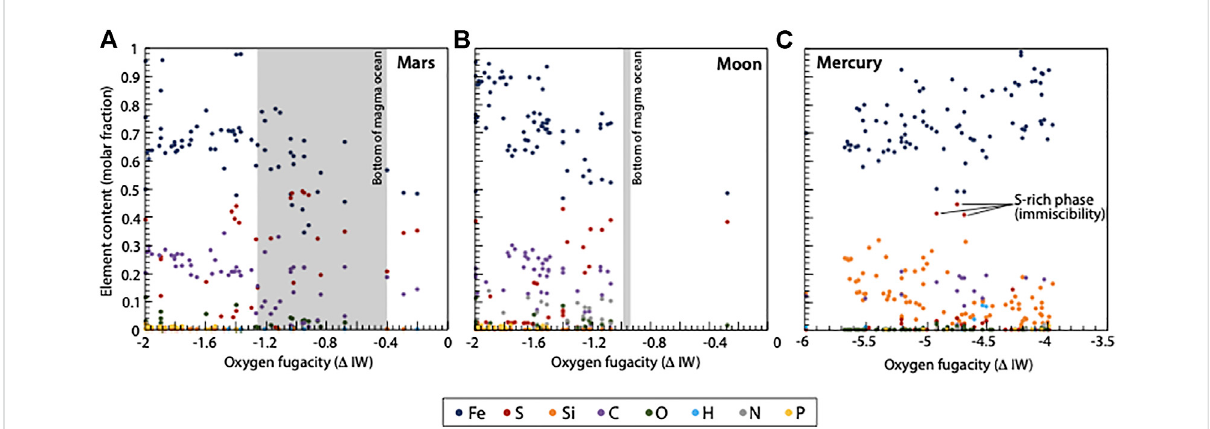
FIGURE 8 Composition of the metallic phase part of silicate-metal partitioning experiments as a function of the estimated oxygen fugacity (relative to the iron – wüstite buffer ( Δ IW)). Experiments were selected for each core according to the conditions listed in Table 1. (A) Results from experiments relevant totheMartiancore; (B) Resultsfromexperiments relevantto theLunarcore; (C) Results fromexperimentsrelevant totheHermeancore.All partitioning data come from studies listed in Supplementary Supplementary Tables S4 – S6.